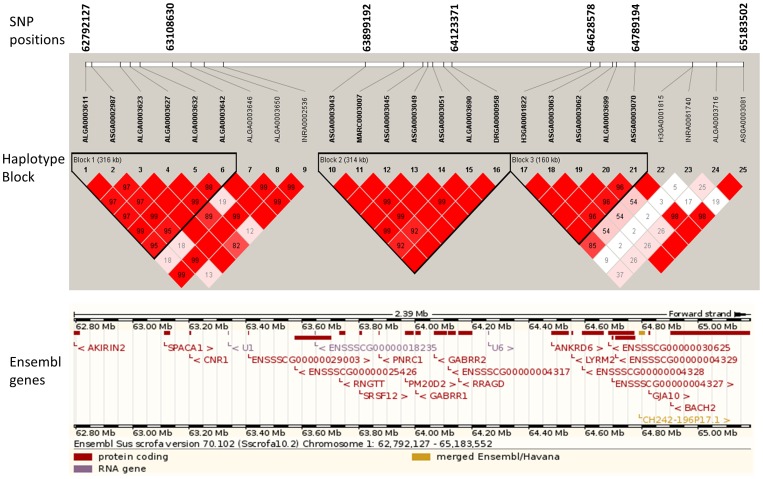
Linkage disequilibrium (LD) pattern and Ensemble genes on region from 62–65 Mb on pig chromosome 1.LD blocks are marked with triangles. Values in boxes are LD (r2) between SNP pairs and the boxes are colored according to the standard Haploview color scheme: LOD >2 and D'  = 1, red; LOD >2 and D'<1, shades of pink/red; LOD<2 and D'  = 1, blue; LOD<2 and D'<1, white (LOD is the log of the likelihood odds ratio, a measure of confidence in the value of D').